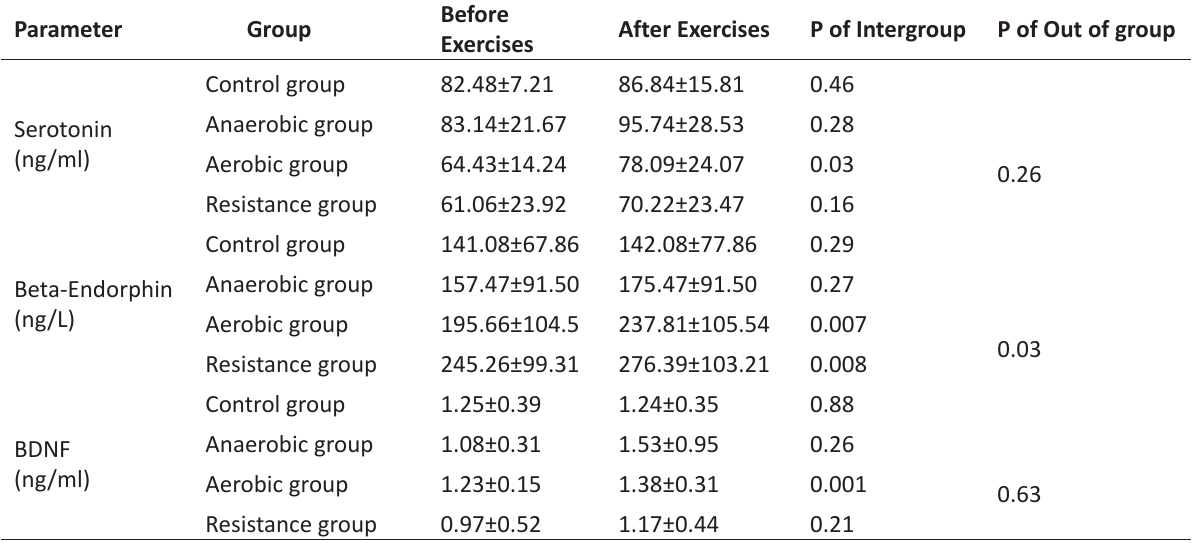
ExercisesBefore